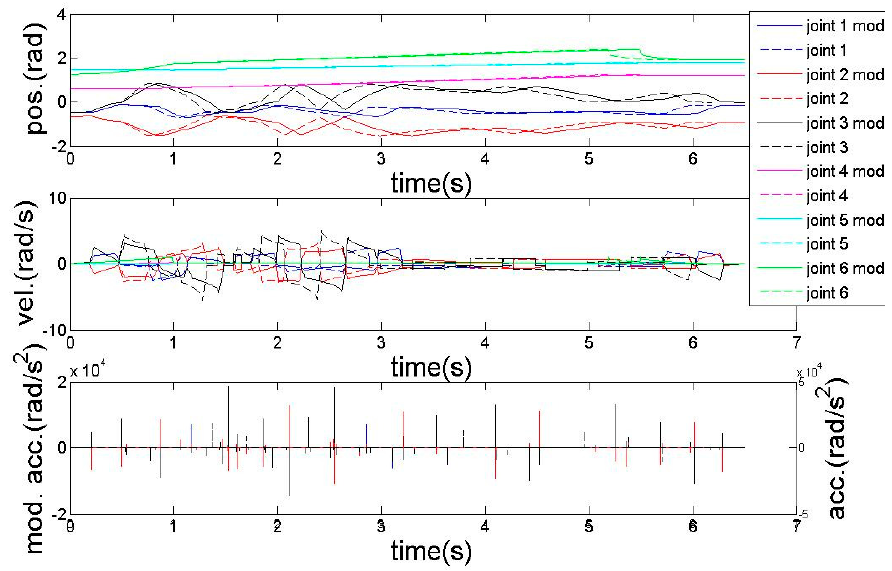
Figure 2. The Cartesian velocity of the Efort robot.